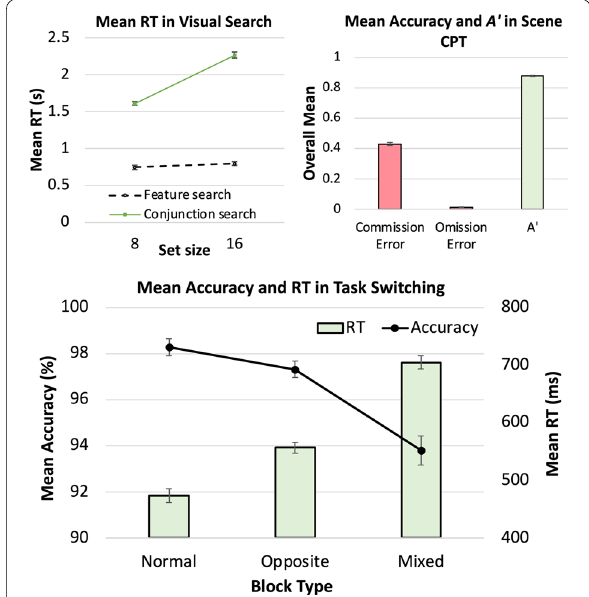
Fig. 2 Results from the attention tasks. Upper left: Mean visual search RT. Upper right: Scene CPT accuracy and A ′ . Lower panel: Mean accuracy (%) and RT (ms) in task switching for each block type. Accuracy is plotted on the line graph corresponding to the y-axis on the left. RT is plotted on the bar graph corresponding to the y-axis on the right. Not plotted is the mean visual working memory accuracy of 58.6% (S.E. 1.0%). Error bars show 1 S.E. of the = ±